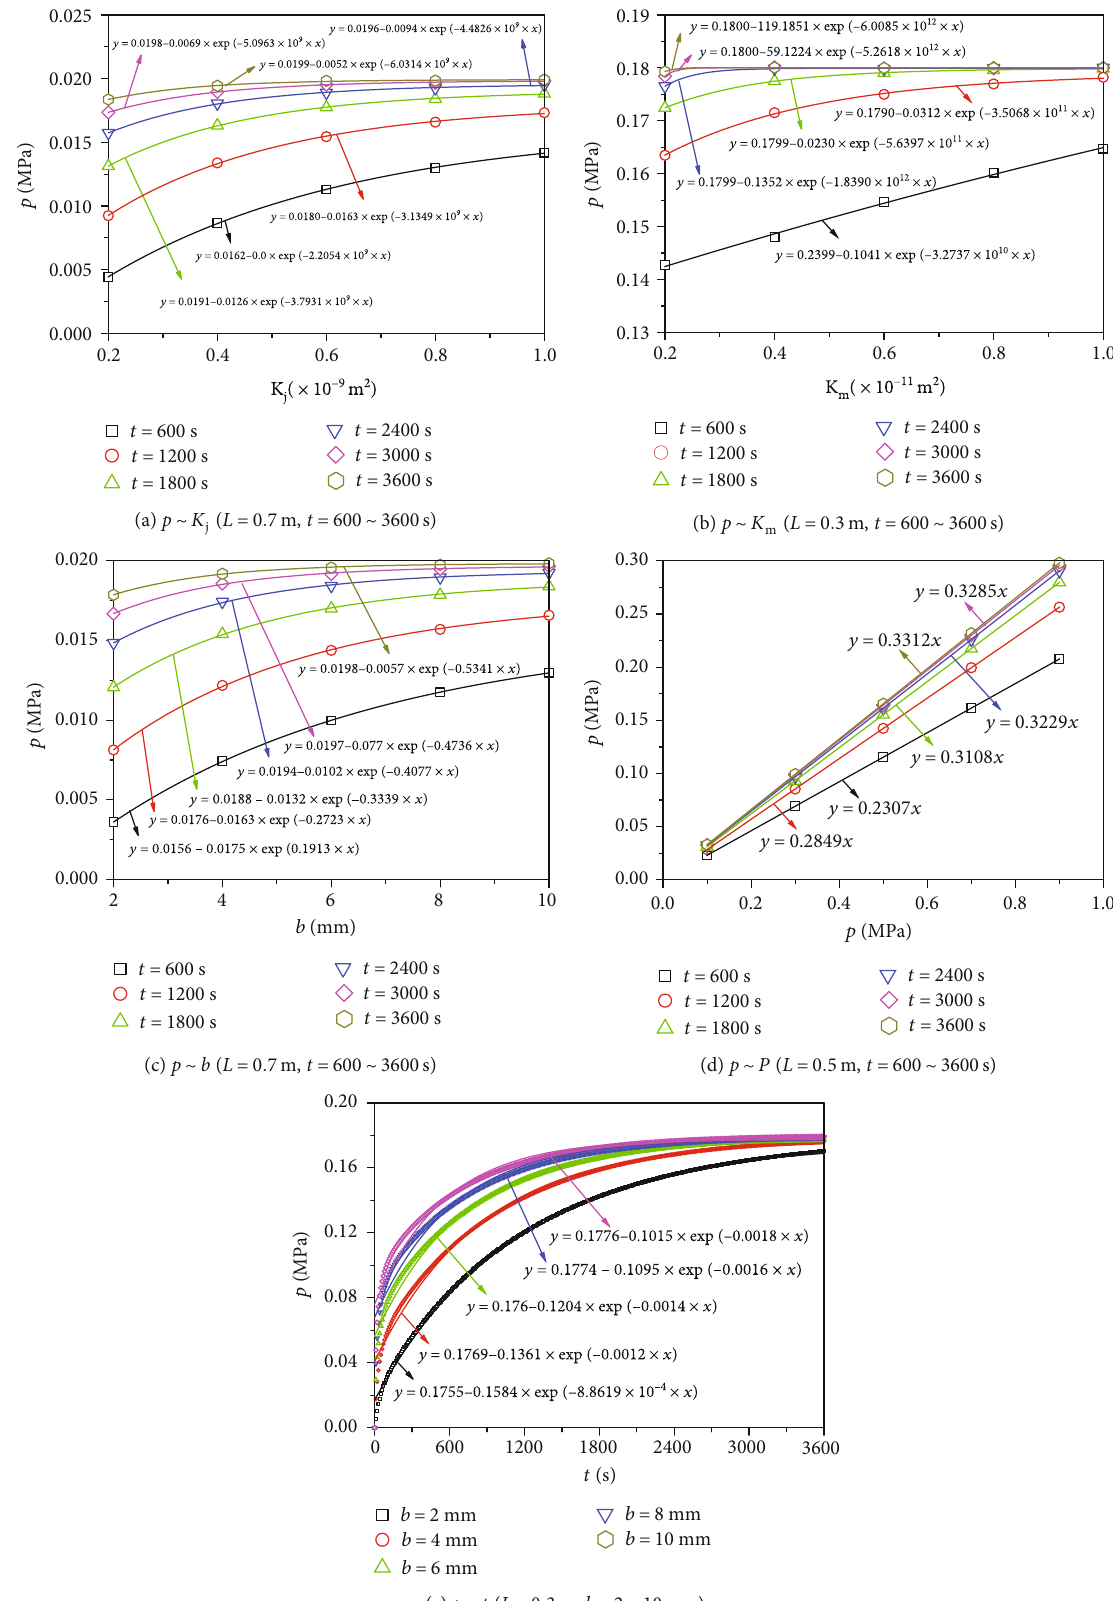
K b , P , and t j , m ,